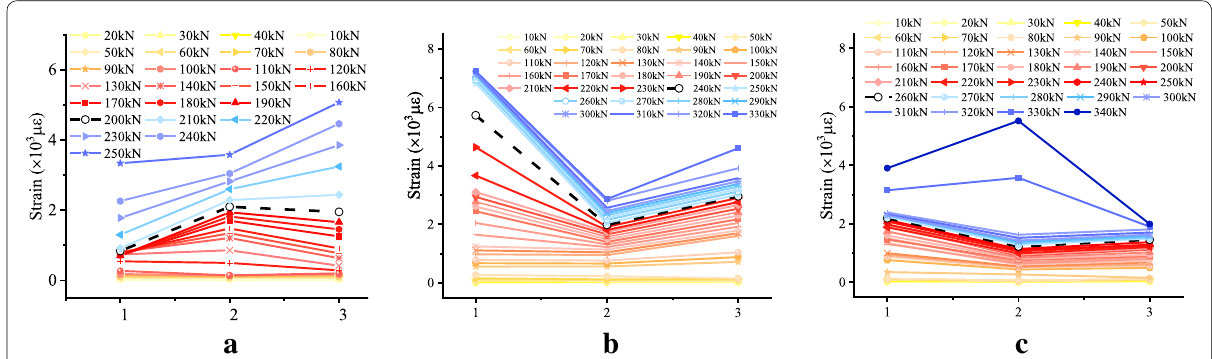
Fig. 18 The changing characteristics of strain-based stressing state modes: a the strain-based stressing state mode of CFRP-strengthened beam B3; b the strain-based stressing state mode of CFRP-strengthened beam B4; c the strain-based stressing state mode of CFRP-strengthened beam